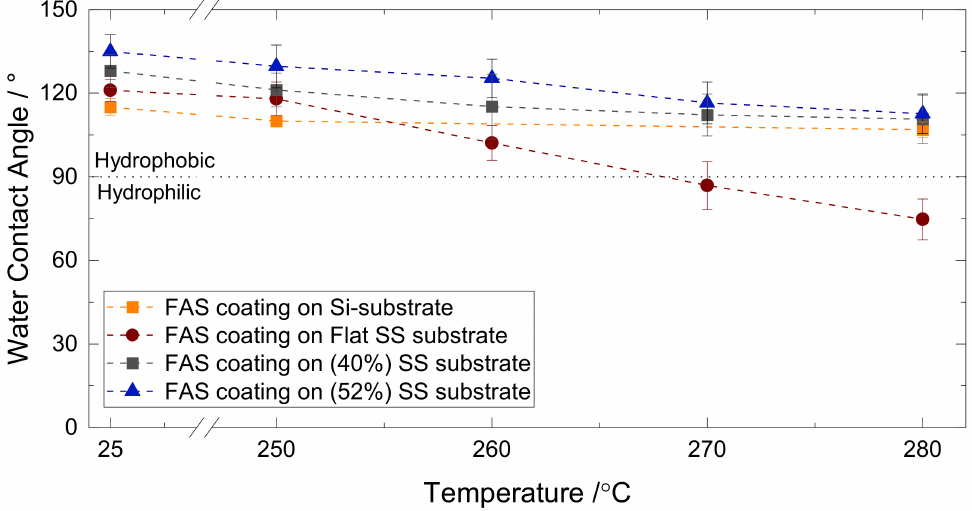
Figure 11. Results of the thermal resistance test for the FAS coating on different